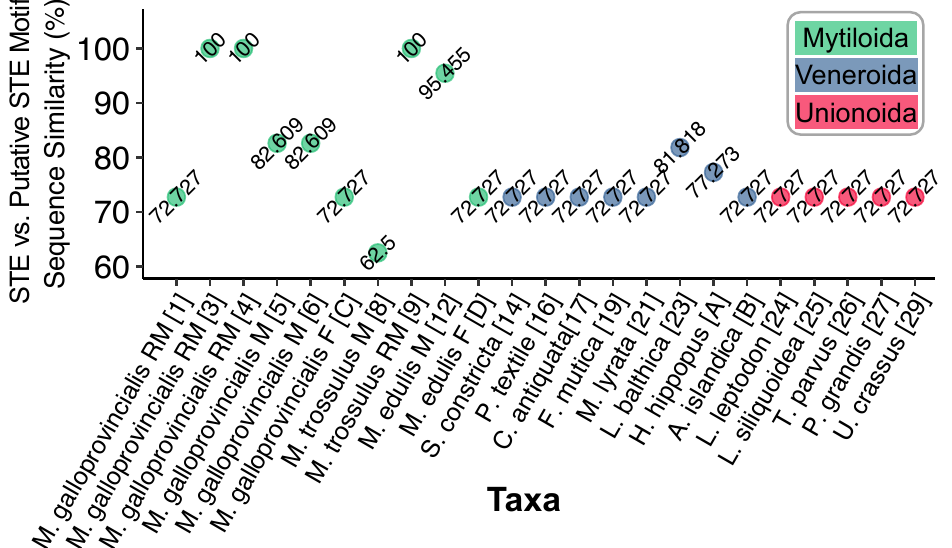
Figure 2. Degree of sequence similarity between STE-like signatures and the known 22 bp STE motif from Kyriakou et al. [10]. Nucleotides were aligned using MUSCLE